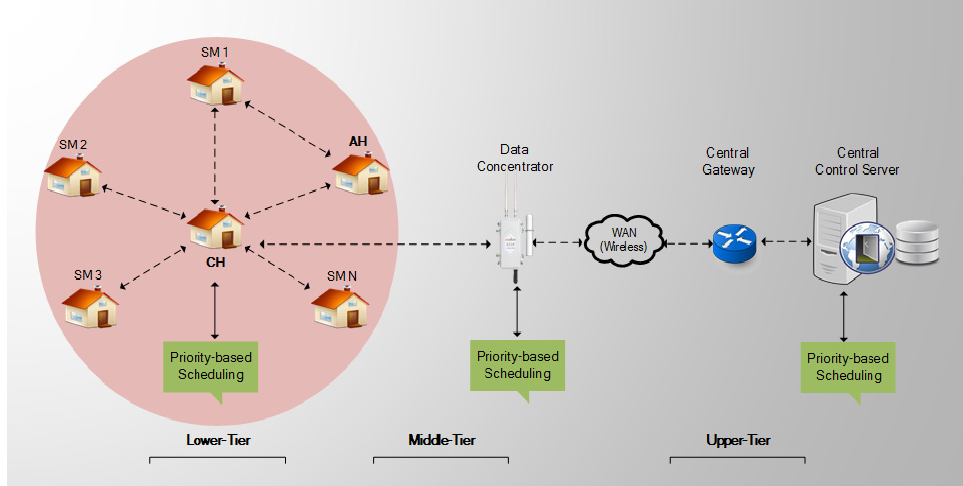
Figure 2. Proposed three-tier hierarchical architecture for AMI applications.